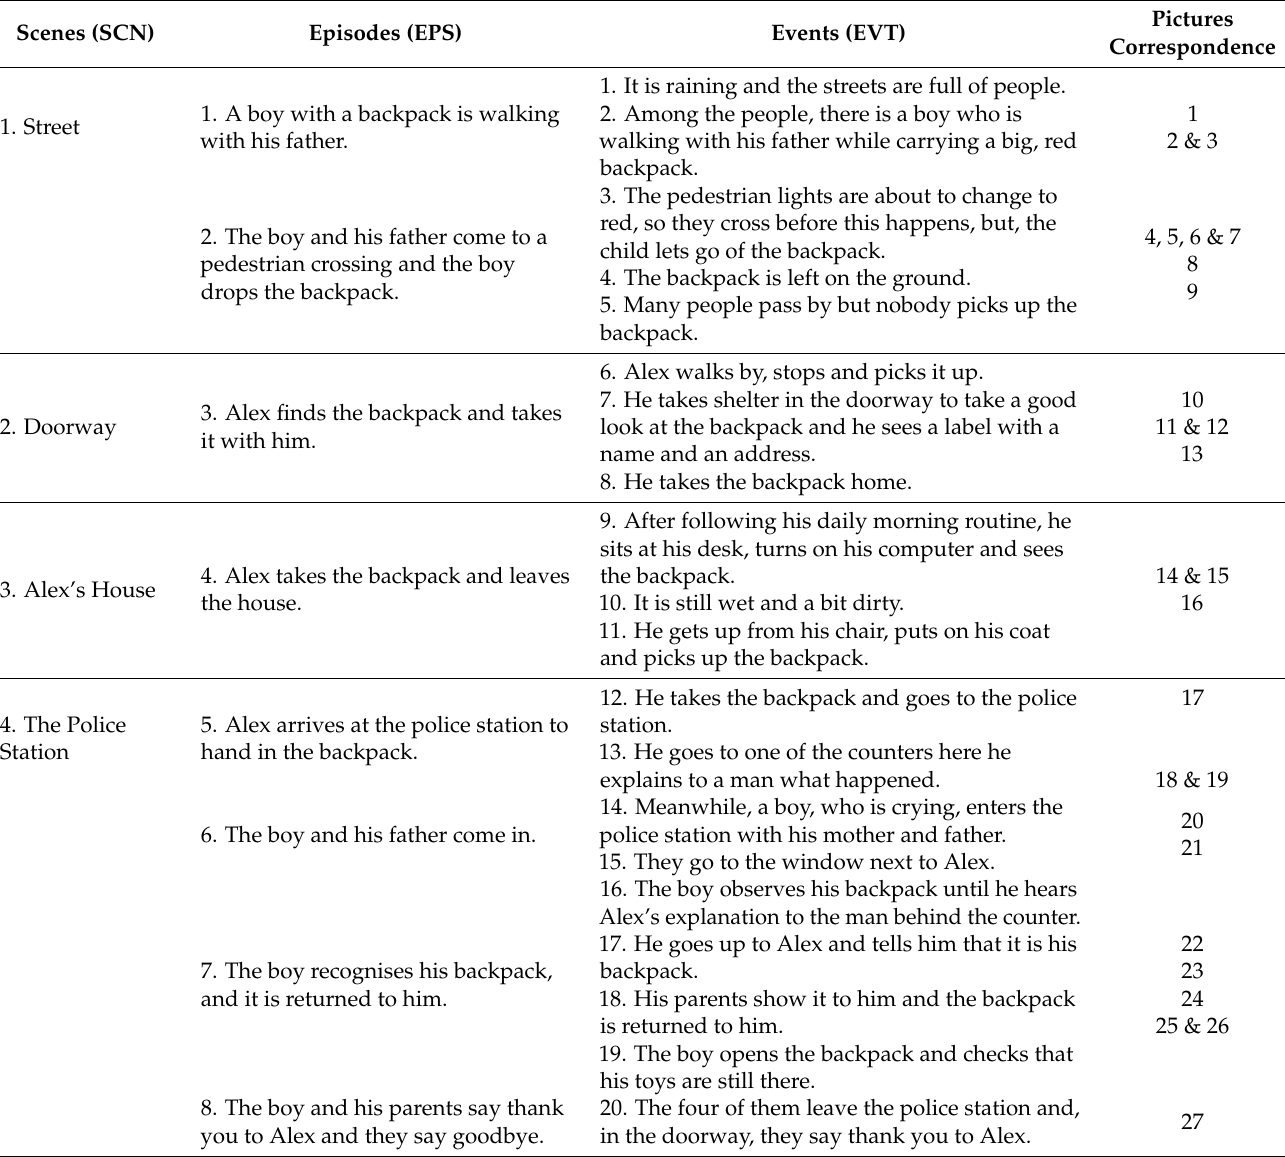
Table 4. “Gold Standard” Scheme for Macrostructure